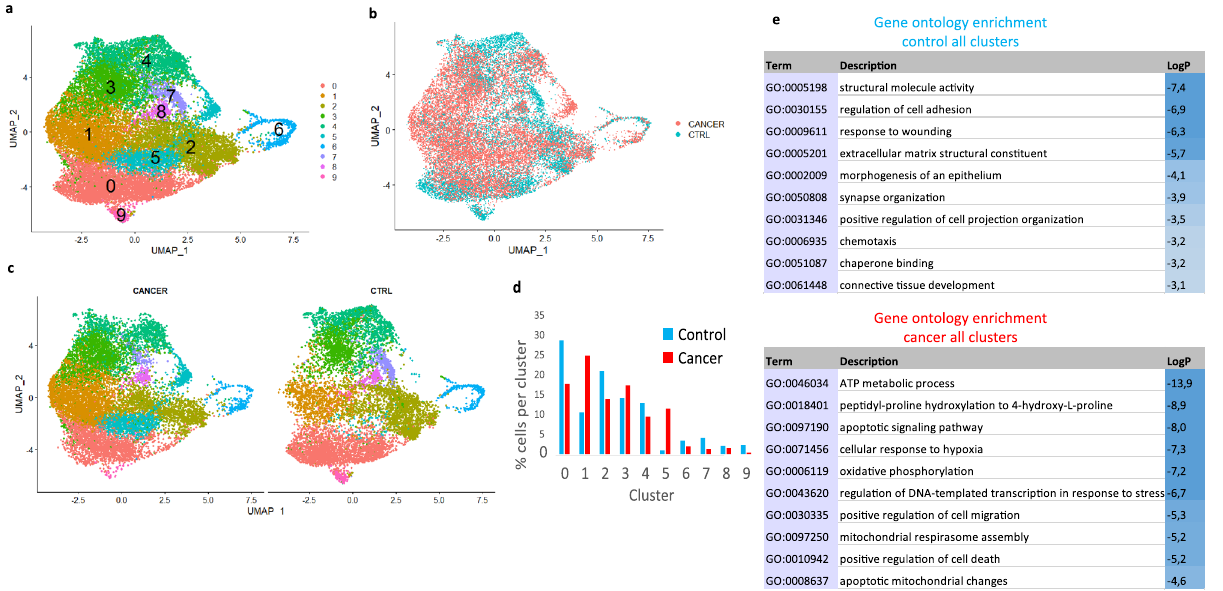
Figure 4. Integration of control and cancer data sets. Uniform manifold approximation and projection (UMAP) plot of the integrated Seurat object with cells labeled based on ( a ) Seurat clusters and ( b ) their origin [control (blue) or cancer (pink)]. ( c ) Integrated object split into separate UMAP plots for control and cancer cells. ( d ) Bar chart depicting the percentage of total cells contributing to each cluster [control (blue bars) and cancer (red bars) cells]. ( e ) Top 10 enriched Gene Ontology biological process terms in all clusters of control organoids when compared with cancer organoids (upper table) and vice versa (lower